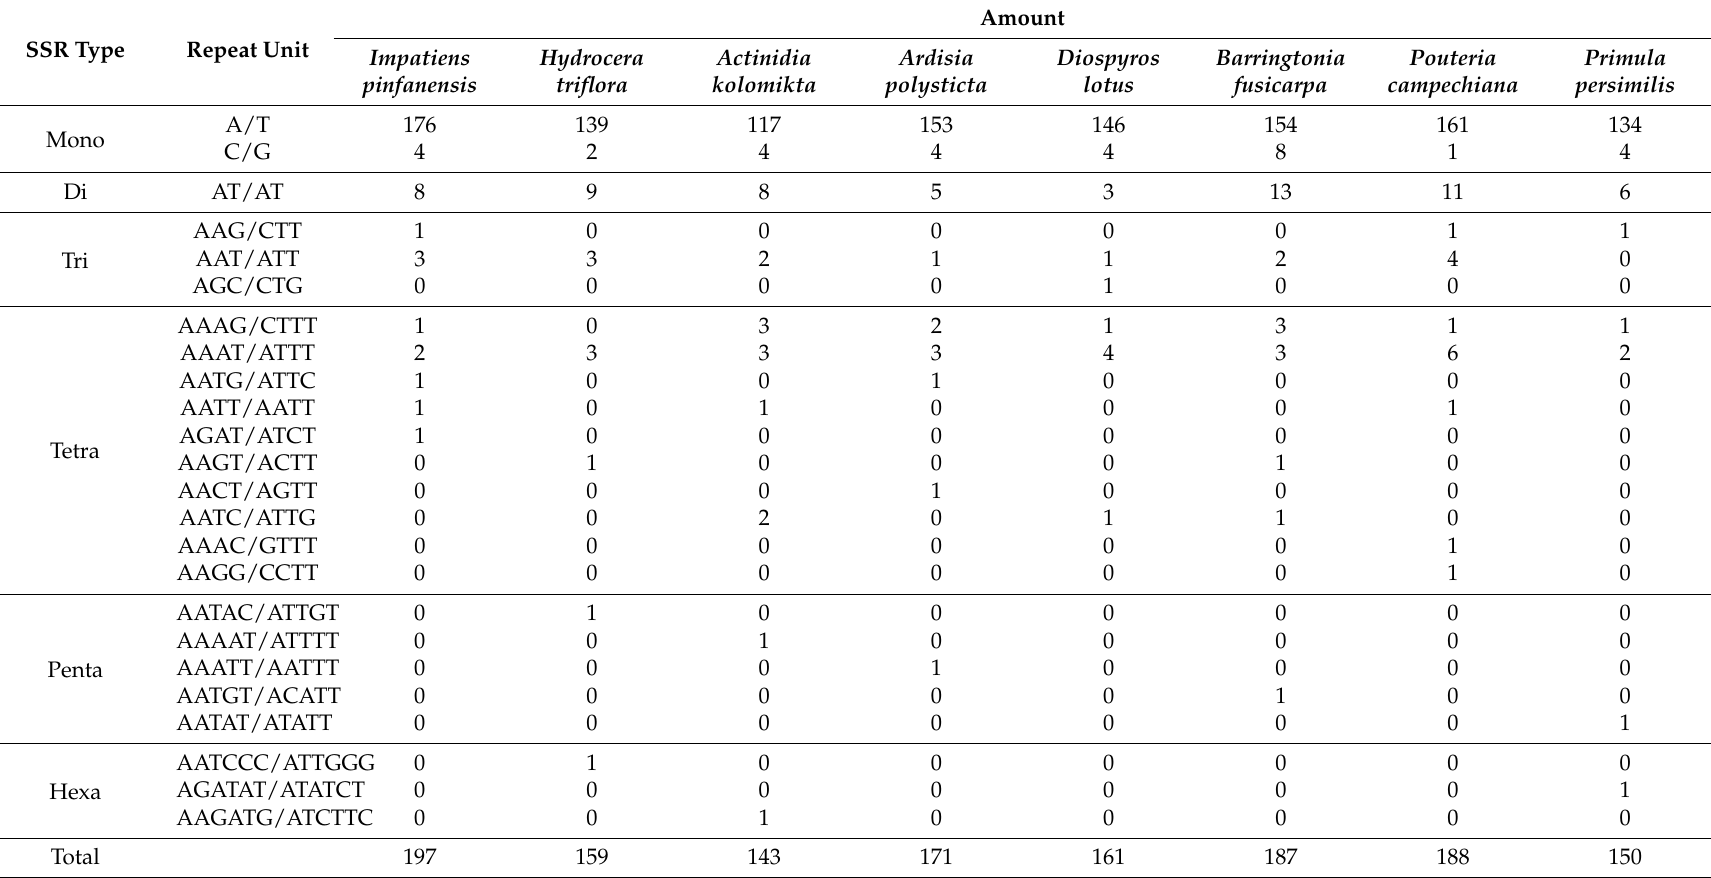
Table 4. SSR types and amount in the Impatiens pinfanensis and Hydrocera triflora Chloroplast